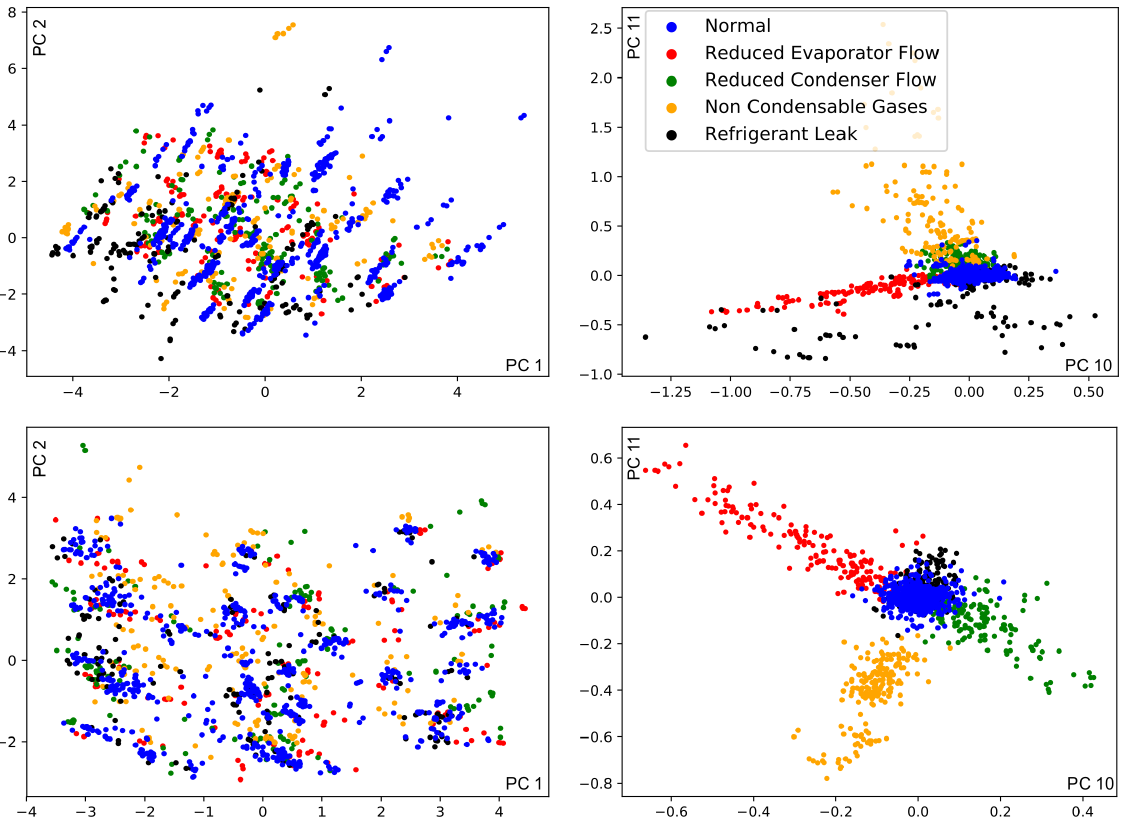
Figure 3. Scatter plot of the principal component and residual space after PCA transformation: upper left: the two first PC (screw compressor), upper right: residual subspace (screw compressor), lower left: the two first PC (centrifugal compressor), lower right: residual subspace (centrifugal